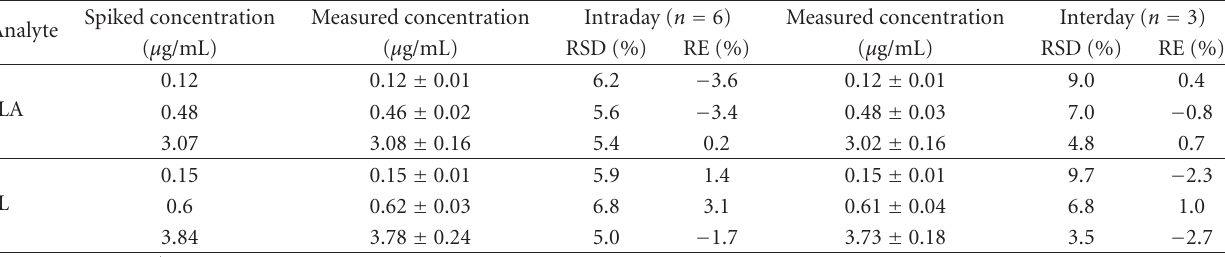
Table 1: Intraday and interday precision and accuracy for QC samples.